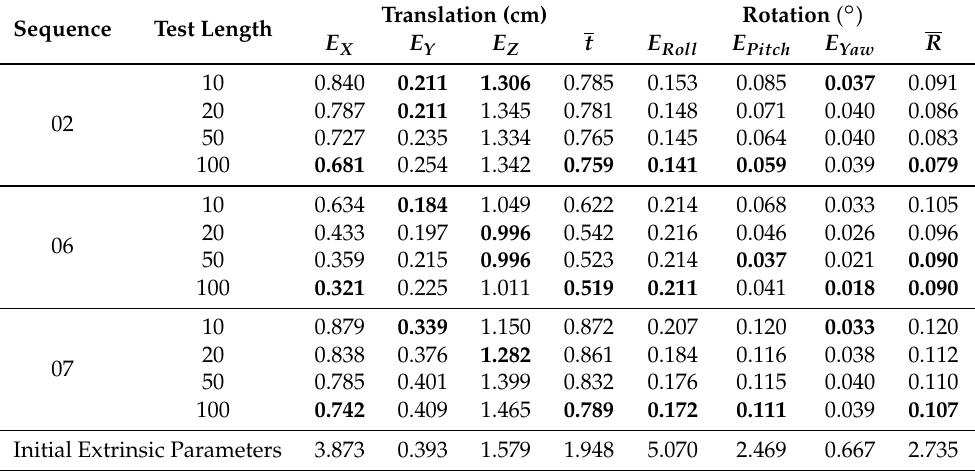
Table 7. The calibration results given initial extrinsic parameters using the KITTI360